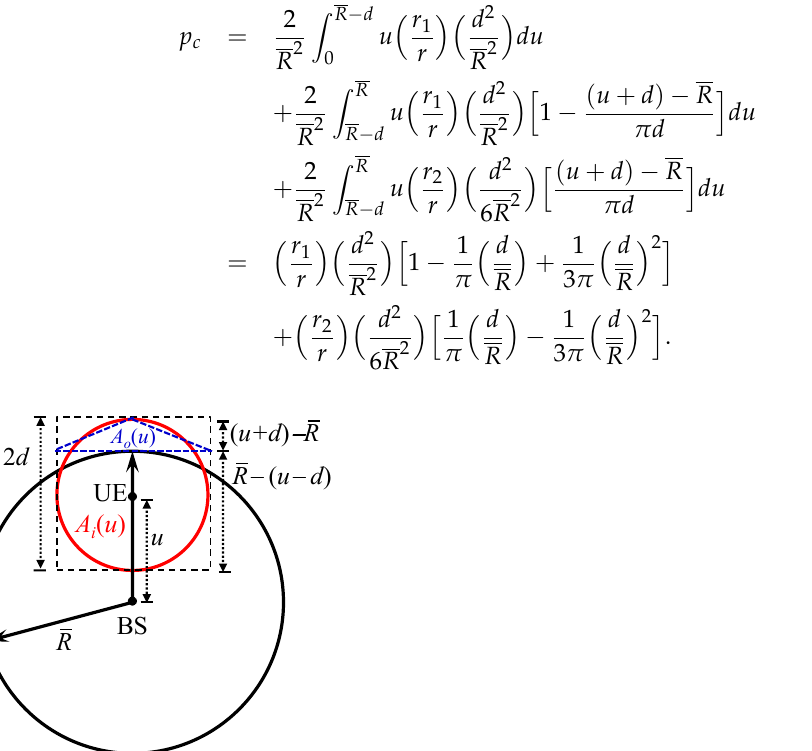
Figure A1. Coverage areas of probing signals in two adjacent